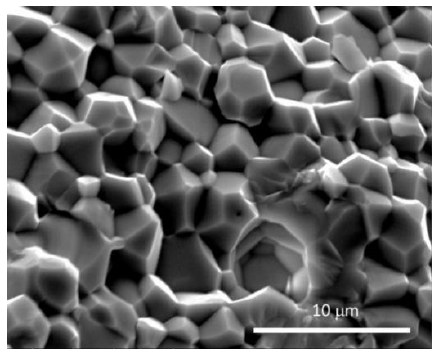
Figure 4. Secondary electron micrograph of sintered BZCY755 fractured cross section (5000×).